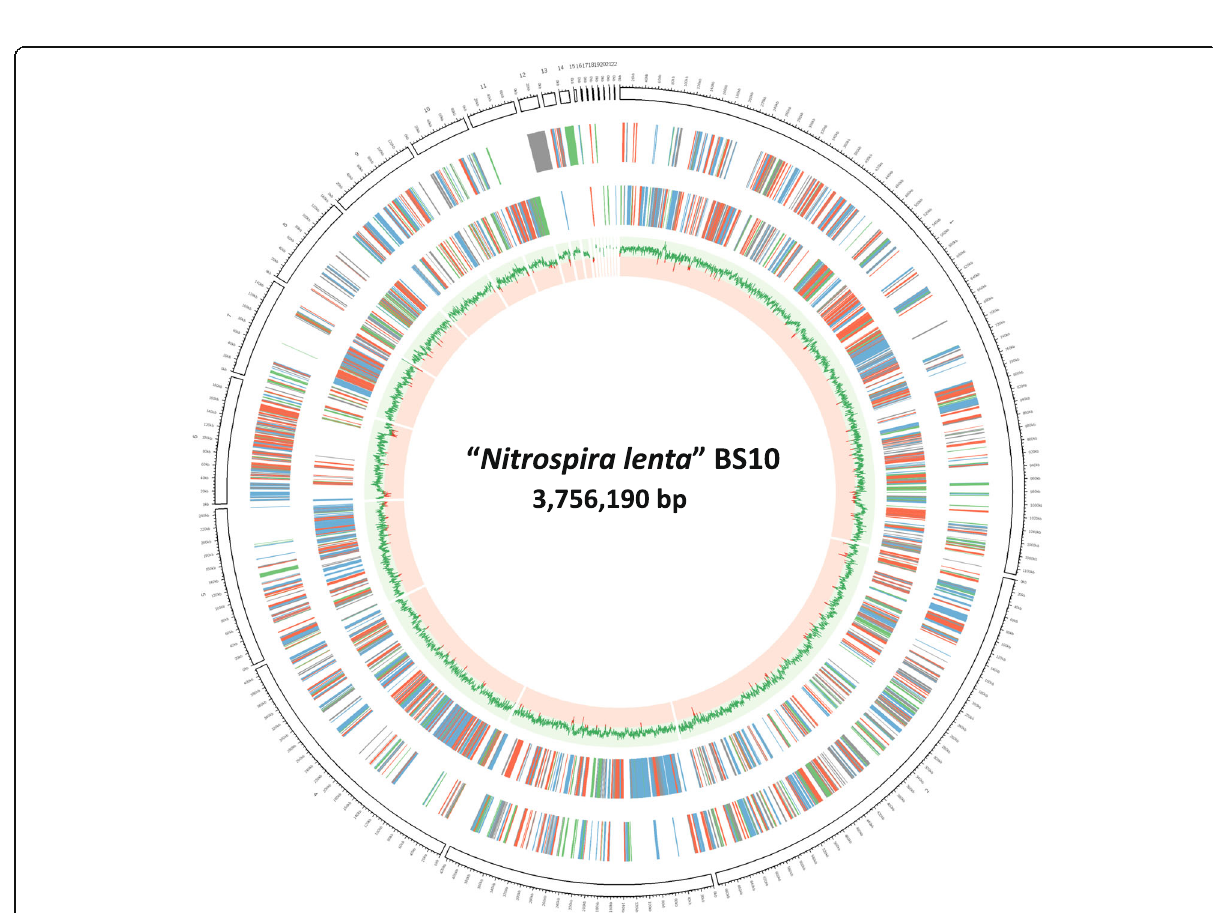
Fig. 3 Circular representation of the “ N. lenta ” genome. From inside out the circles display: (1) G + C content (red < 50%, green > 50%), (2) CDS on reverse strand, (3) CDS on forward strand, (4) contig organization. The tick marks correspond to 20 kbp. CDS colors indicate COG classification (blue, cellular processes and signaling; green, information storage and processing; red, metabolism, grey; poorly characterized). Contigs are ordered by size, and their arrangement in the figure may not reflect the positions of the respective regions on the chromosome. The graphical circular map of “ N. lenta ” chromosome was generated using the CIRCOS software